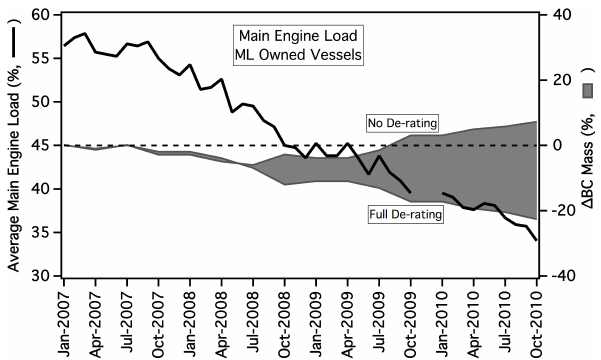
Fig. 4. Average main engine load change for the Maersk fleet (black line). Reproduced with permission from AP Moller-Maersk (deKat, 2011). The potential range of BC mass changes due to the Maersk speed reduction program is also shown as the shaded region.